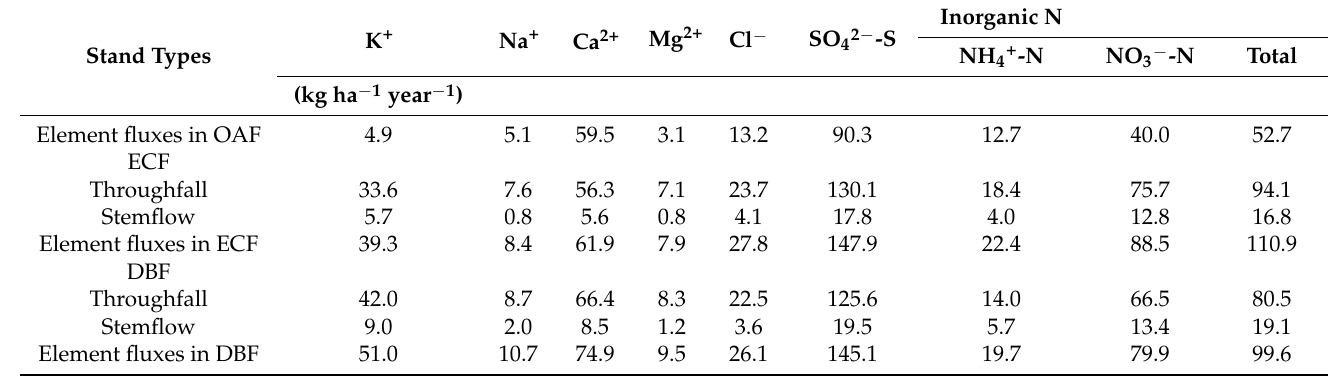
Table 2. Annual element fluxes in the OAF, ECF, and DBF in 2015. OAF: open area field; ECF: evergreen coniferous forest; DBF: deciduous broadleaved